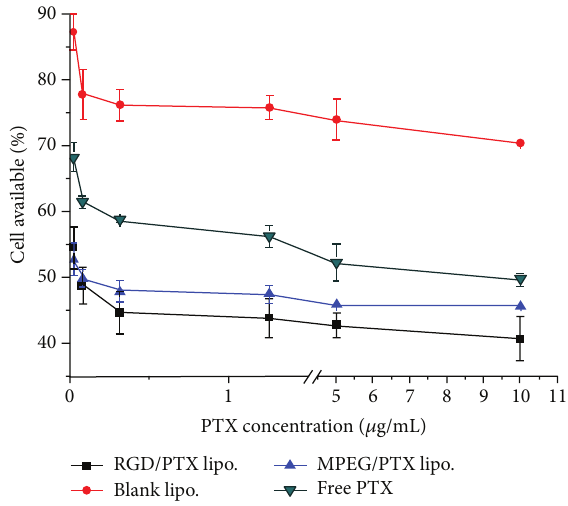
Figure 10: Cytotoxicity of free PTX, blank liposome, PTX liposome, and RGD-PTX liposome for B16F10 tumor